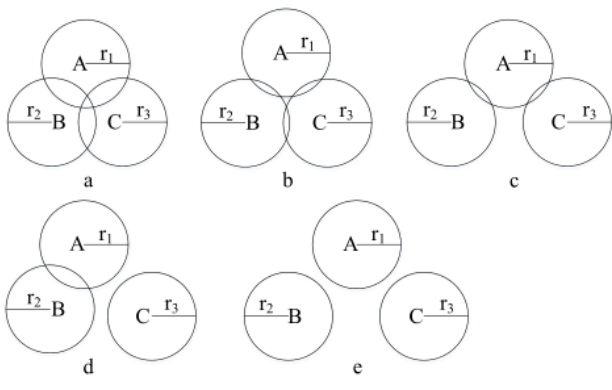
Figure 4. Possible error